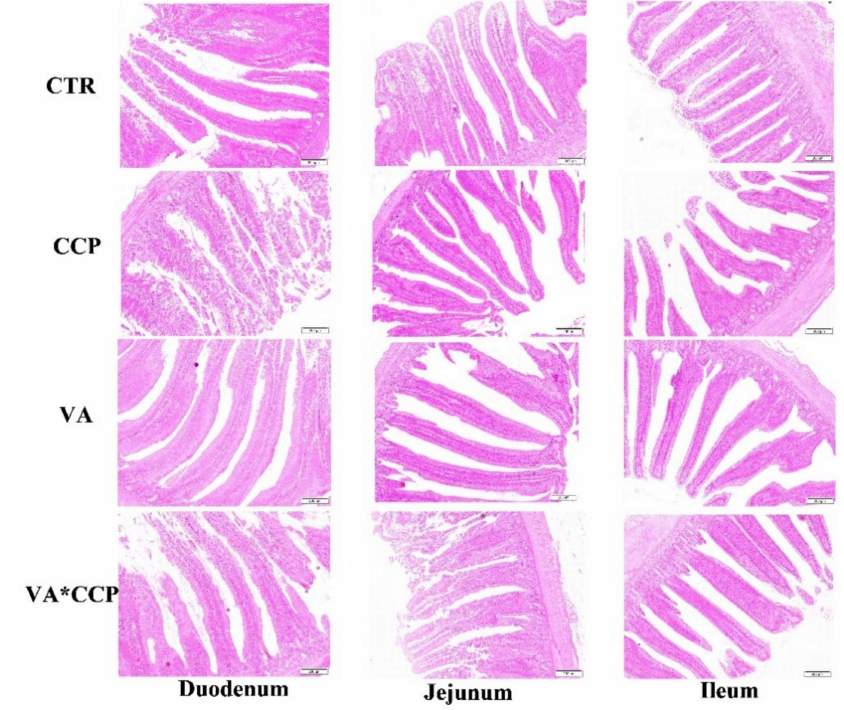
Figure 2. The intestinal morphological parameters on day 35. CTR = control group; CCP = co-infected with coccidia and C. perfringens group; VA = dietary supplementation with 12,000 IU/kg VA group; VA* CCP = VA × CCP = dietary supplementation with 12,000 IU/kg VA and co-infected with coccidia and C. perfringens group. Each image has a 200 µ m scale, and the image is magnified 100